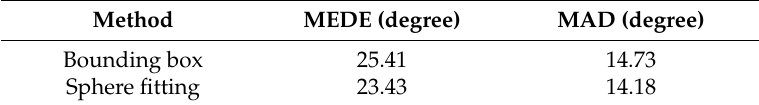
Table 3. Median error (MEDE) and median absolute deviation (MAD) of the 3D pose errors.